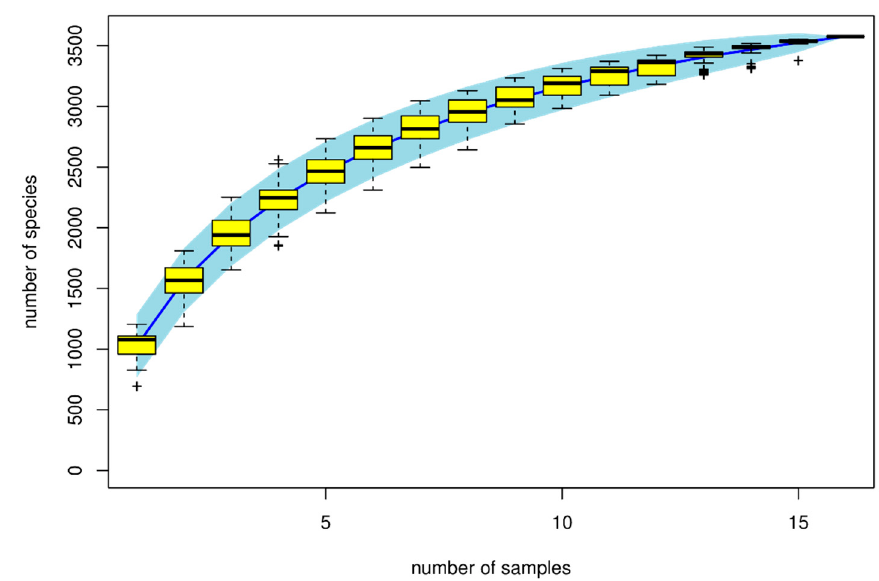
Figure 2. Speccacum species curve. The abscissa represents the sample size, the ordinate represents the number of species being detected, and the blue shade reflects the confidence interval of the curve.